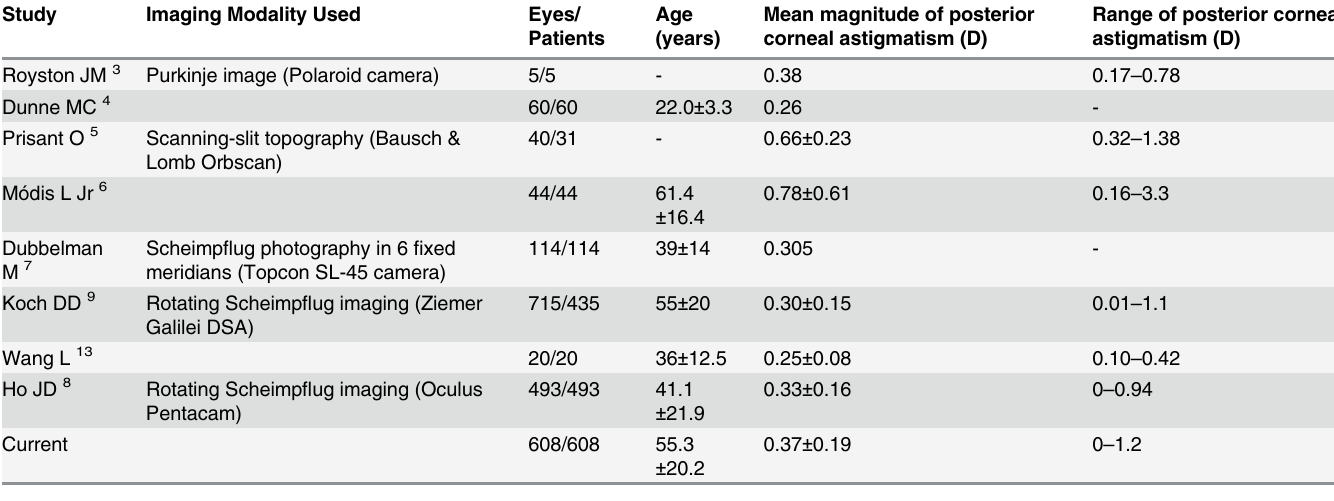
Table 2. Published values of posterior corneal